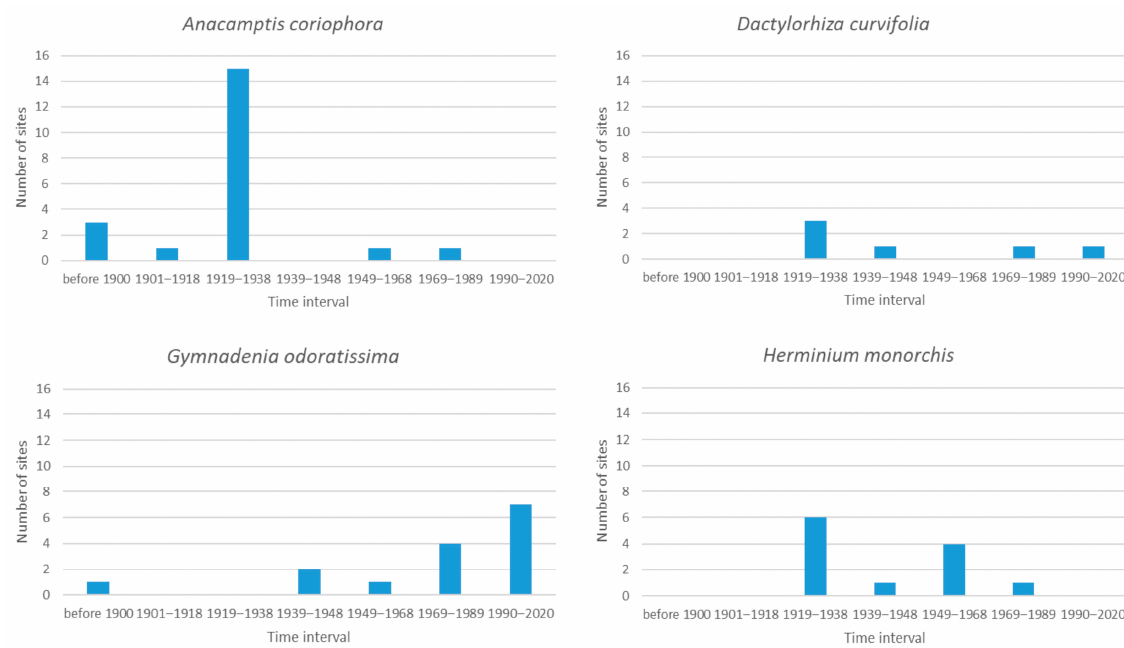
Figure 1. The number of sites in particular intervals for the four species that are now considered to be extinct in the Czech Republic.